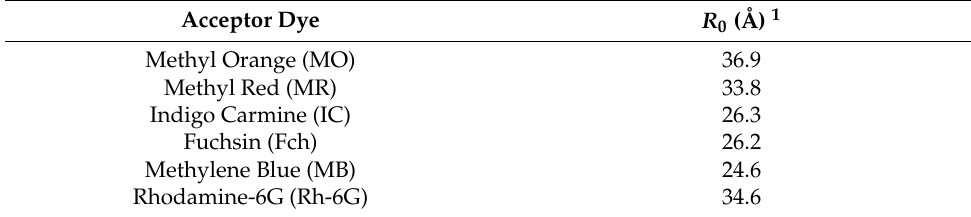
Figure 9. Normalized emission spectrum (blue line; excitation at 340 nm) of WP-CDs (0.1 mg/mL) and absorption spectra of ( a ) MO, ( b ) MR, ( c ) IC, ( d ) Fch, ( e ) MB, and ( f ) Rh-6G, all in phosphate buffer (pH = 7.2). Table 2. Critical energy transfer distances ( R 0 ) for RET between WP-CDs and several dyes.